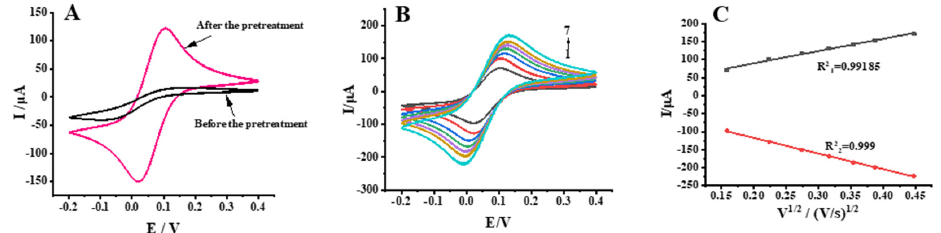
Figure 3. ( A ) Cyclic Voltammetry before and after bare electrode pretreatment; ( B ) Cyclic voltammograms of bare GCE at scan rates of 0.025, 0.050, 0.075, 0.100, 0.125, 0.150, 0.200 V/s (1 − 7); ( C ) The inset shows the dependence of the redox peak currents on the square root of scan rates.